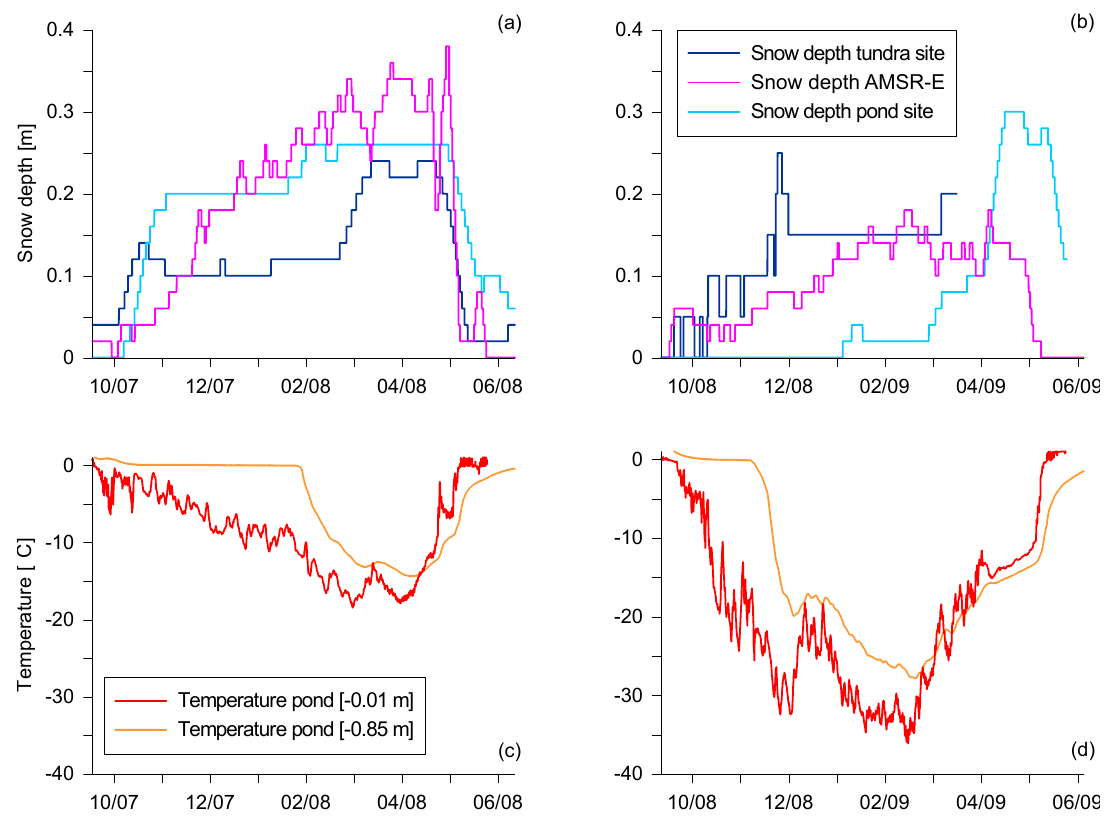
Fig. 4. The diagrams at the top show the evolution of the snow depth measured at the tundra site (polygonal center) and the pond site during the winter periods of (a) 2007 and (b) 2008. Moreover, we depict the snow depth inferred from the AMSR-E snow water equivalent product using a snow density of 190kgm − 3 for both periods. The diagrams at the bottom depict the temperatures observed at the surface and the top of sediment of the investigated polygonal pond for the winter periods of (c) 2007 and (d) 2008.